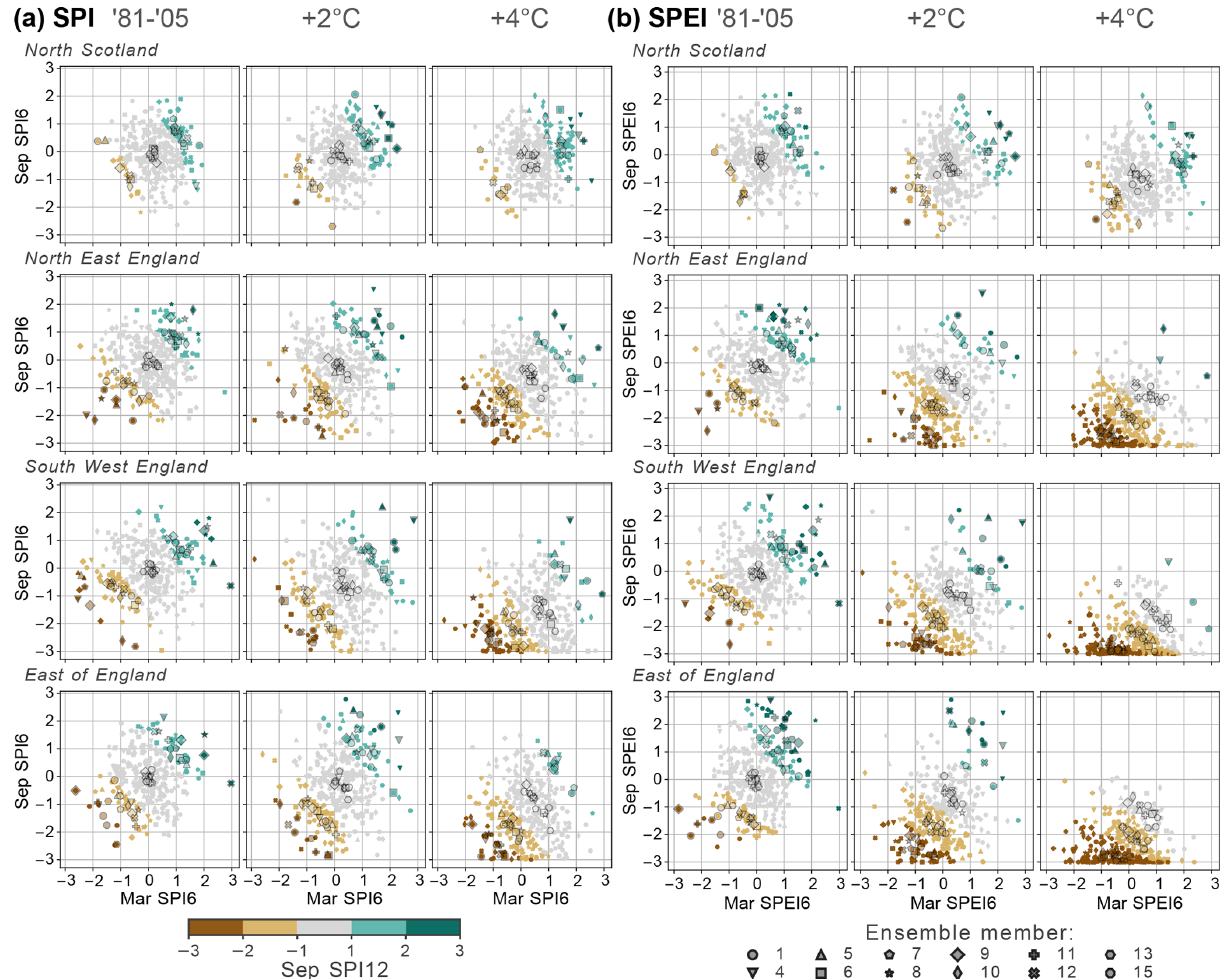
Figure 8. Values of the September SI12 (hydrological year) plotted against the September SI6 (hydrological summer) and the March SI6 (hydrological winter) from the same year used to compute SI12 for the SPI (a) and the SPEI (b) . All years are shown for each time slice and ensemble member. SI6 values that exceed − 3 or + 3 are plotted at − 3 or + 3 respectively. The larger, transparent markers show the centroids of five SI12 classes: extremely dry, dry but not extremely dry, normal, wet but not extremely wet, and extremely wet. The reader is referred to Figs. S4 and S5 for results for all 13